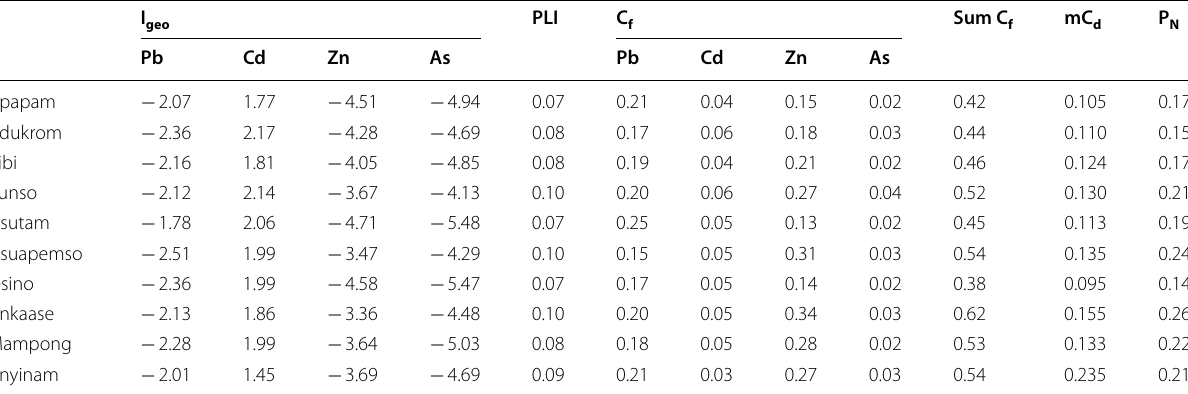
Table 7 Geo-accumulation Index, contamination degree, pollution load index and contamination factor of the surface sediment in the Birim River